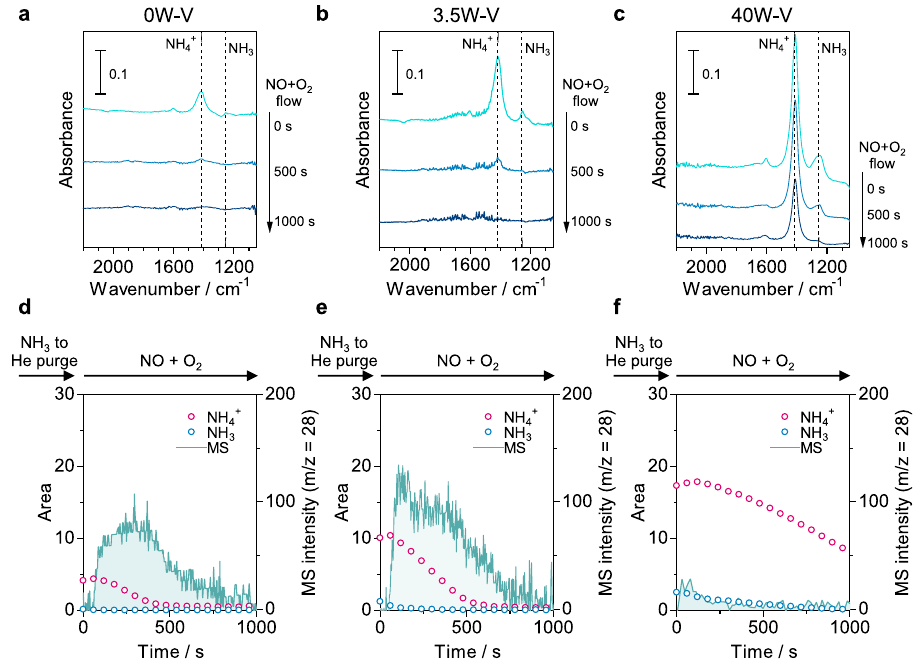
Fig. 6 Acid properties under a dry atmosphere. a – c Operando IR spectra of ad species on 0W – V (without tungsten), 3.5W – V (with tungsten), and 40W – V (excess tungsten) during NH 3 adsorption followed by NO + O 2 exposure at 150 °C under a dry condition. The IR disc was exposed to 0.1% NH 3 /He fl ow (30 min) and purged with He (20 min), followed by exposure to 500 ppm NO + 8% O 2 (He balance) fl ow. d – f IR peak areas of ammonia species adsorbed on Lewis acid sites (NH 3 ) and Brønsted acid sites (NH 4 + ) and MS intensity of N 2 versus time of NO + O 2 fl